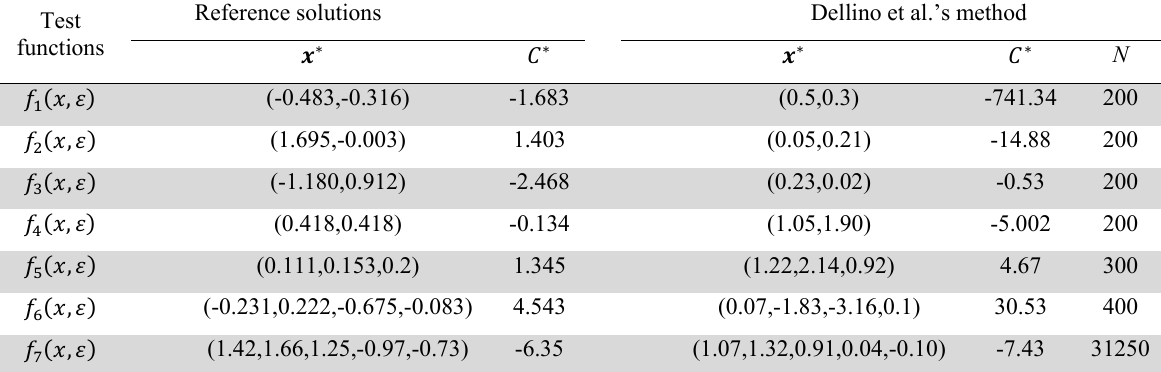
Reference solutions and results of the Dellino et al. method for the seven test